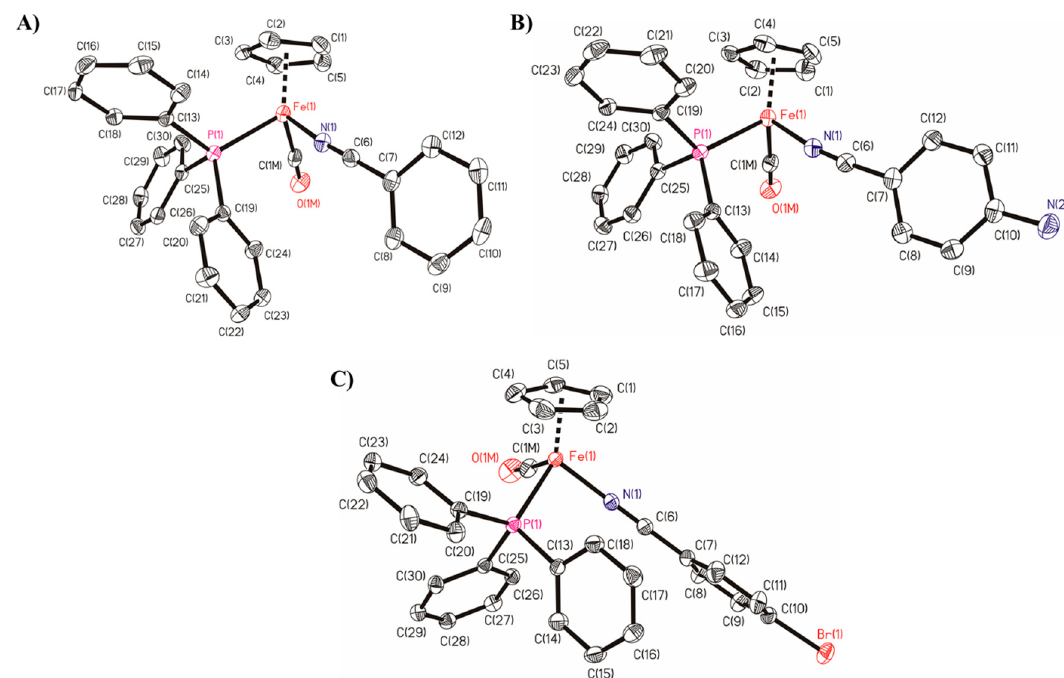
Figure 3. ORTEP for the cations of complexes ( A ) [Fe( η 5 -Cp)(CO)(PPh 3 )(NCPh)] + 1 , ( B ) [Fe( η 5 -Cp)(CO)(PPh 3 )(p-NCPhNH 2 )] + 4 and ( C ) [Fe( η 5 -Cp)(CO)(PPh 3 )(p-NCPhBr)] + 5 . All of the non-hydrogen atoms are presented by their 50% probability ellipsoids. Hydrogen atoms are omitted for clarity.